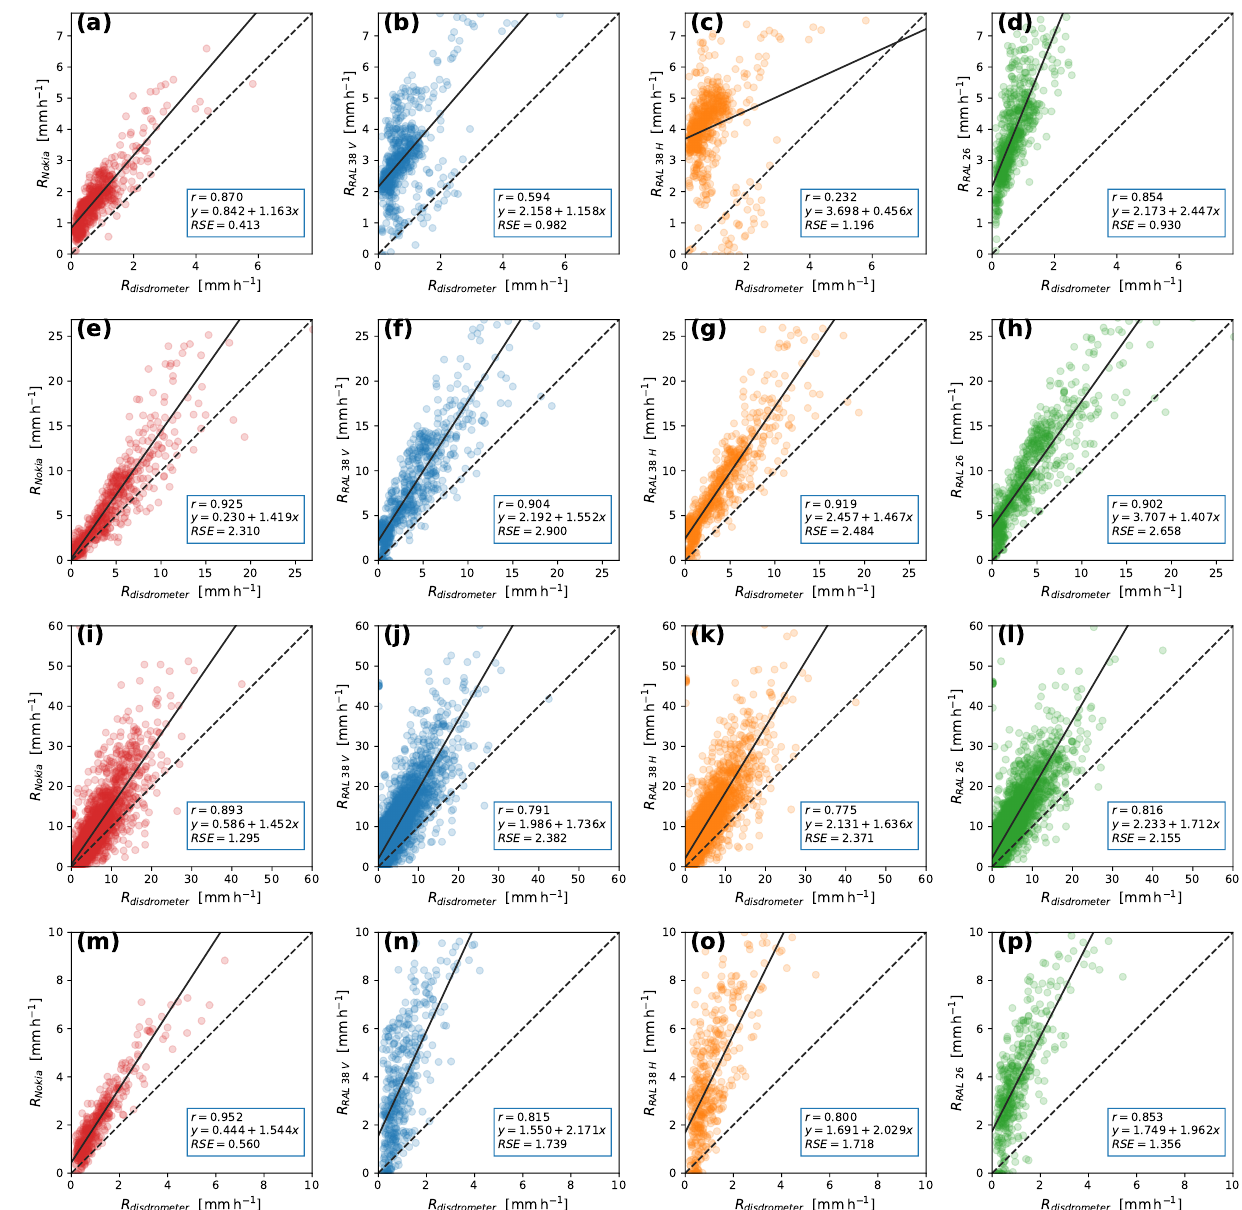
Figure 7. Scatterplots of link-derived rainfall intensities vs. disdrometer-derived rainfall intensities. Solid lines indicate a linear least-squares fit, dotted lines indicate the 1 : 1 line. Within each plot the correlation coefficient ( r ), the fitted line function and the residual standard error (RSE) are also shown. Links from left to right: Nokia, RAL 38 GHz vertical, RAL 38GHz horizontal, and RAL 26GHz. From top to bottom: 24 November 2015 (down-sampled to 30s), 4 November 2015 (down-sampled to 30s), whole dataset down-sampled to 30s, and whole dataset down-sampled to